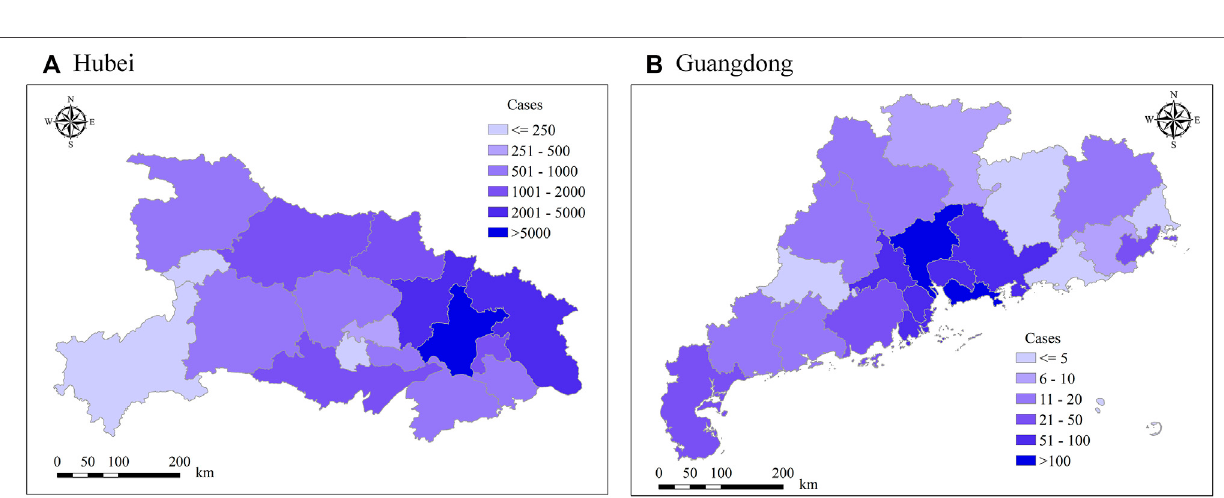
Frontiers in Environmental Science |